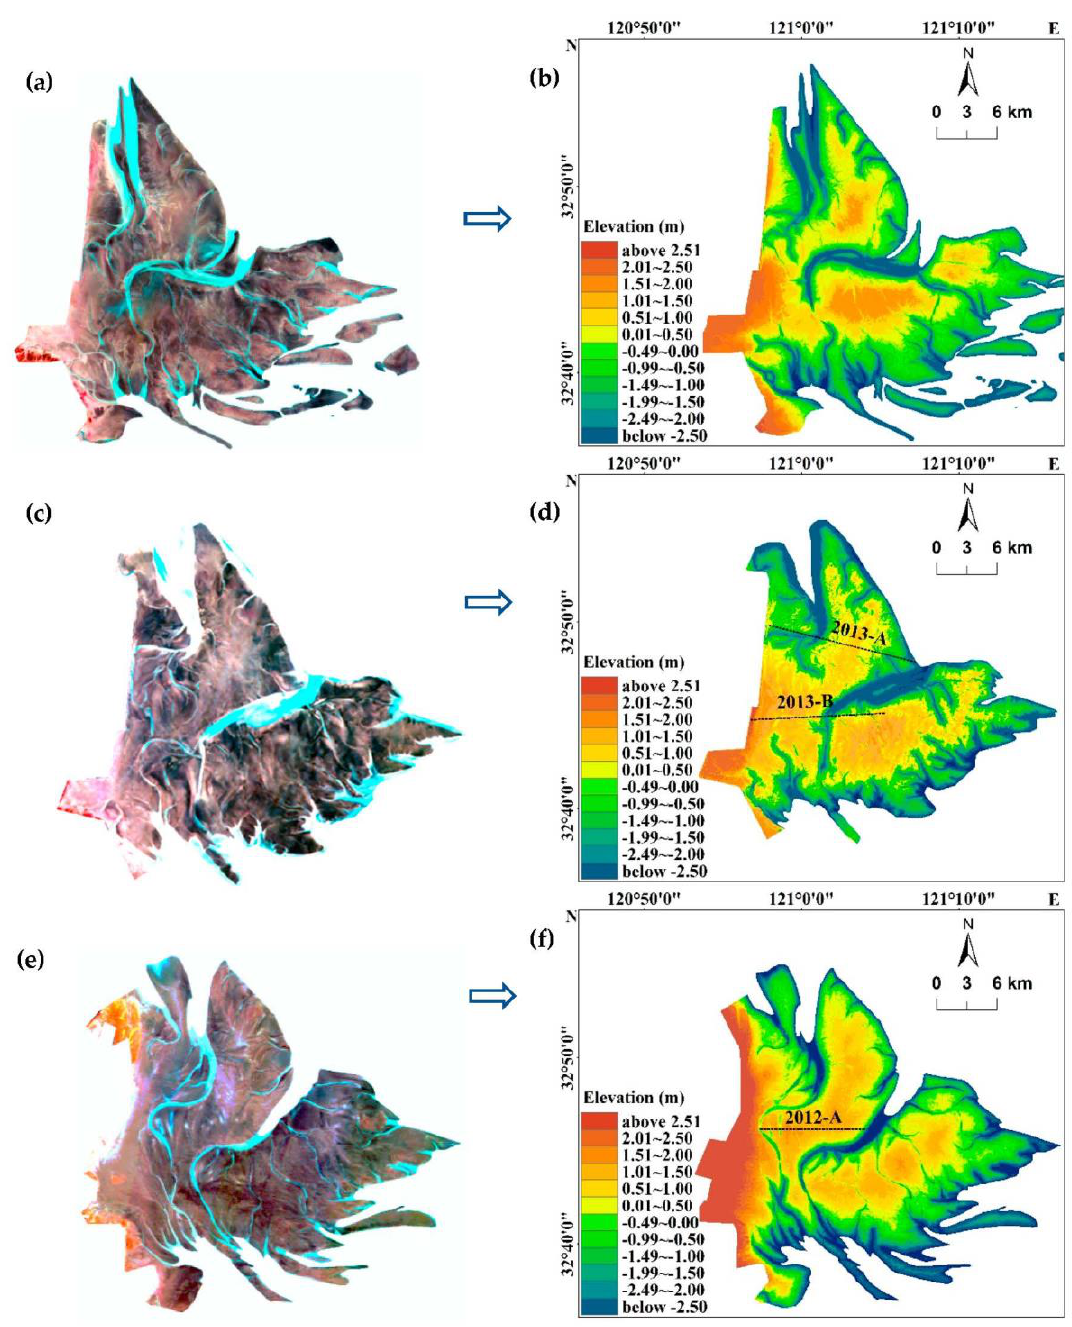
Figure 6. HJ-1 images and corresponding result DEMs: ( a ) image from 21 March 2014; ( b ) DEM for 21 March 2014; ( c ) image from 11 July 2013; ( d ) DEM for 11 July 2013; ( e ) image from 11 February 2012; ( f ) DEM for 11 February 2012.